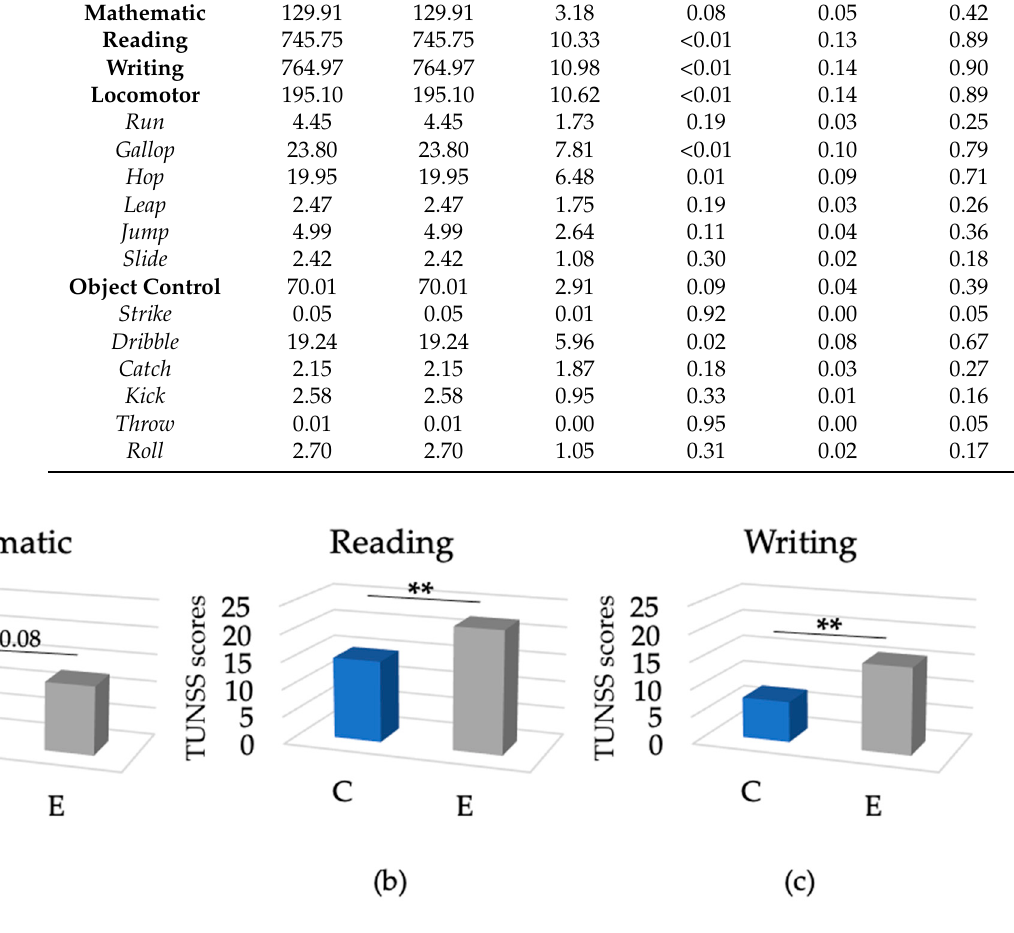
Table 2. Analysis of covariance (ANCOVA) for the cognitive and motor skills by group condition (no-Eduball vs. Eduball group). Result of pre-test was set as the covariate. Skills SS SM F p η p 2 OP Mathematic Reading